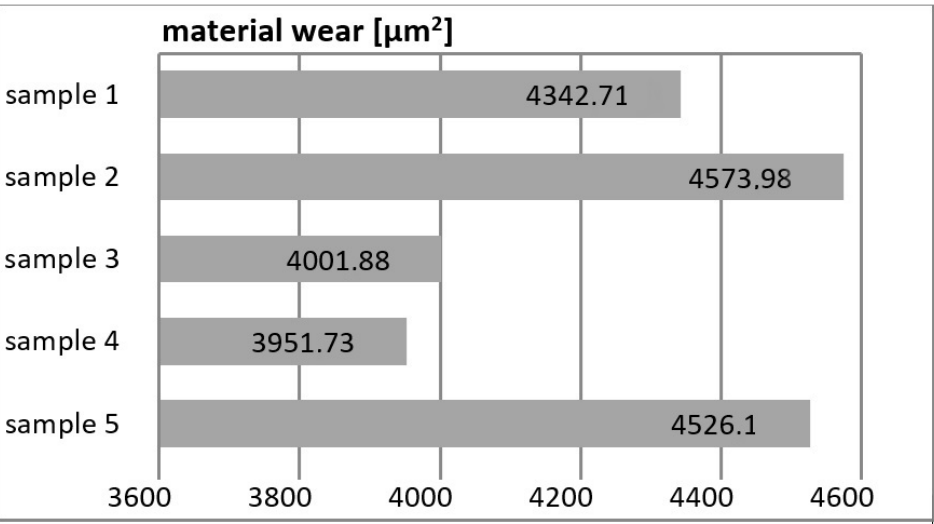
Figure 5. Wear of samples. Figure 5. Wear of